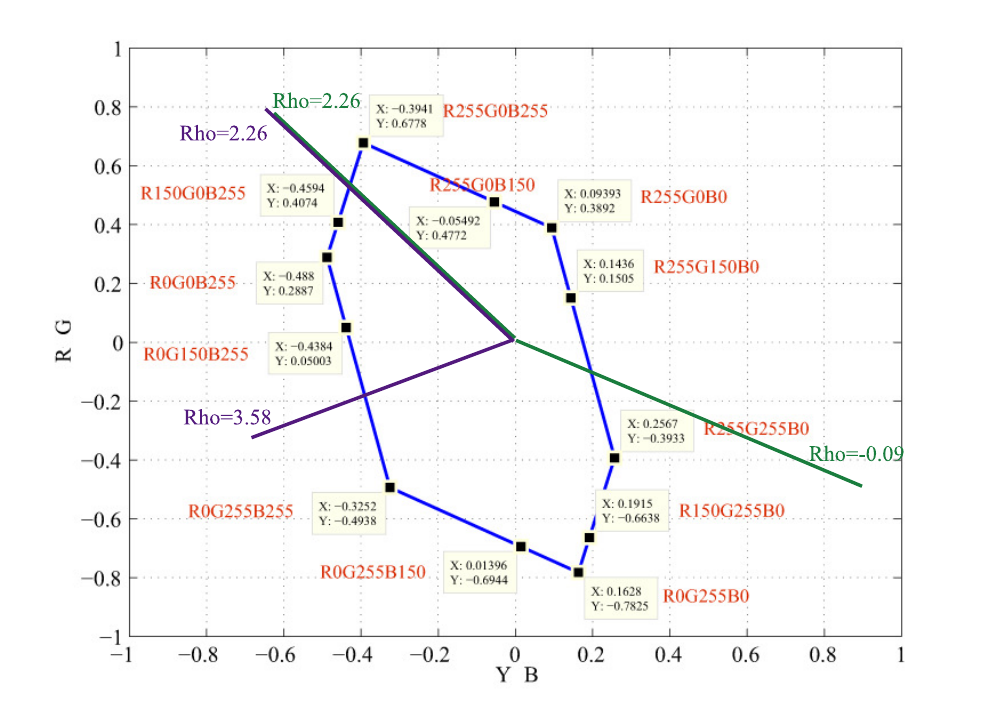
Figure 7. The pure colors RGB (0, 150, and 255).